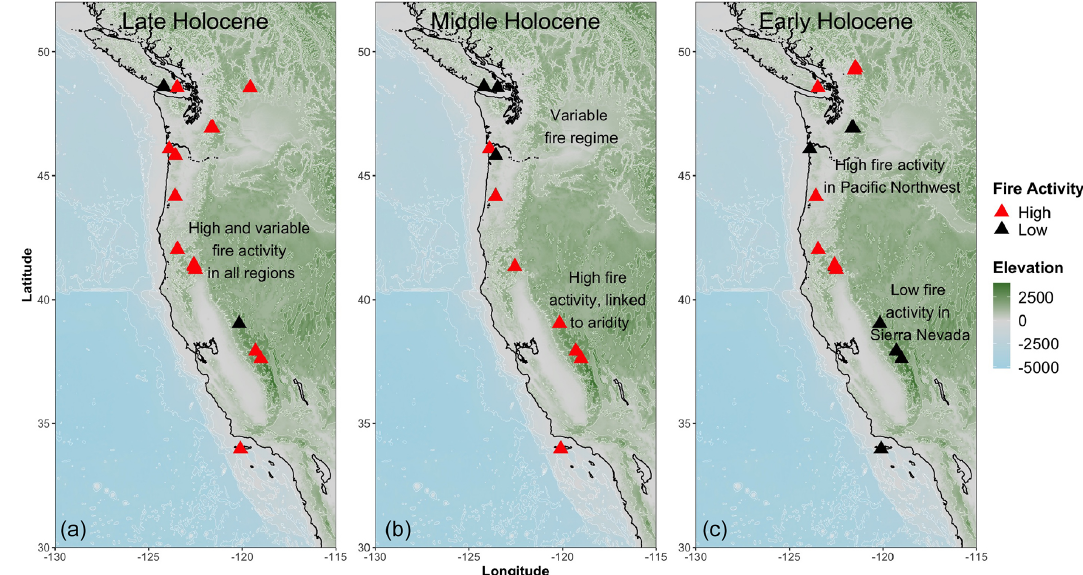
Figure 3. Fire activity as reconstructed by charcoal records through the Early (11.7–8.2ka, c ), Middle (8.2–4.2ka, b ), and Late (4.2–0ka, a ) Holocene; red indicates high fire activity, and black indicates low fire activity. Multiple metrics for fire activity are used; interpretations of original authors are